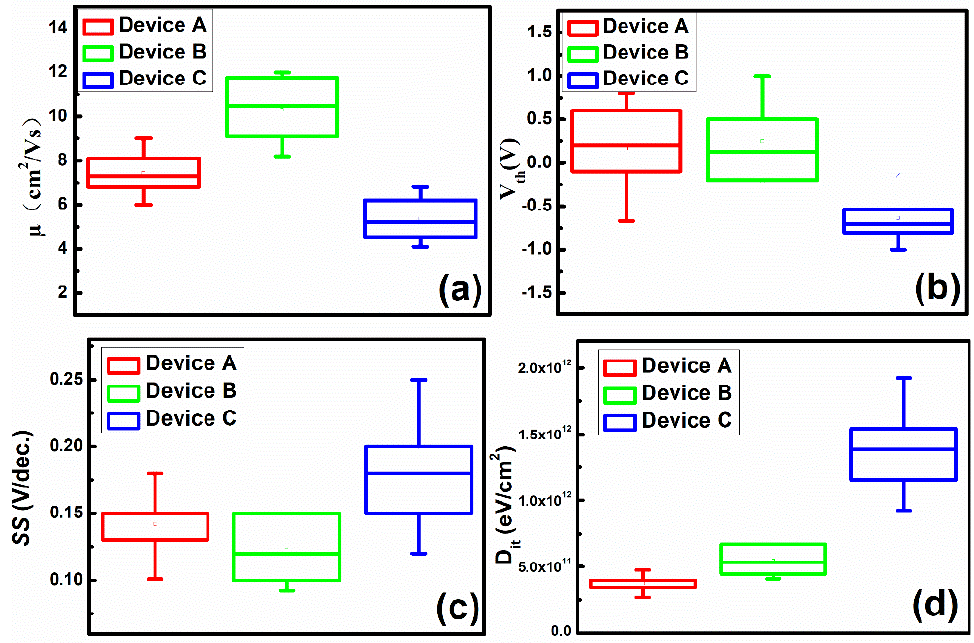
Figure 6. The electrical performance ( a ) μ , ( b ) V th , ( c ) SS , and ( d ) D it for device A, B, and C.